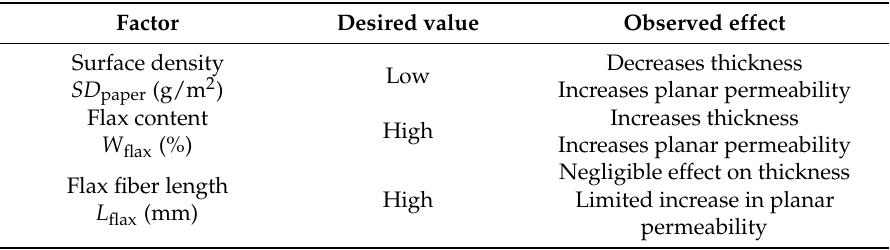
Table 4. Summary of important results on paper